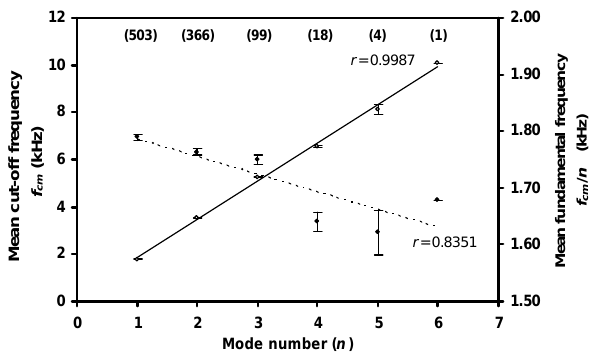
Fig.3. Variation of mean cut-off frequency, f cm , (solid line) and mean fundamental Fig. 3. Variation of mean cut-off frequency, f cm , (solid line) and frequency, f cm / n , (dashed line) with mode number, n . The error bars indicate standard error mean fundamental frequency, f cm / n , (dashed line) with mode num- in the estimated frequency. The numbers in parentheses indicate the total number of tweeks analyzed. ber, n . The error bars indicate a standard error in the estimated fre- quency. The numbers in parentheses indicate the total number of tweeks